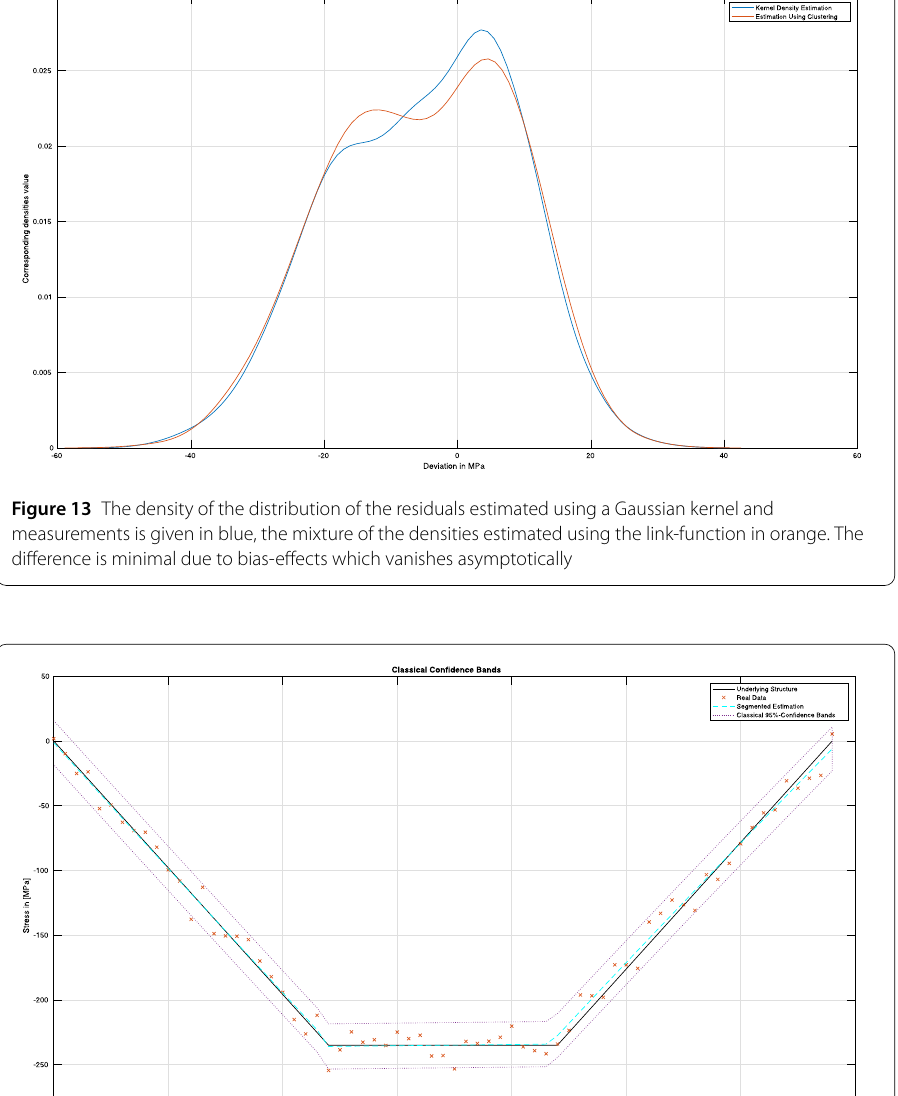
estimation of the stochastic moments possible. It allows the adaption of the confidence band given the distribution of the residuals specifically for all points. Assuming the link- function to be consistent, the parameter of the mixture of Gaussians could be estimated consistently, see Fig. 13 and cf. [24], for details, with known asymptotic distribution and the following confidence bands for a 4-point-bending-test, see Fig. 14 and Fig. 15. Finally, the combination of the yield limit gives bounds for the constants ˜ c and might lead to the decomposition of the constant in residual and normal stress or the identification of plas- ticising areas, see [18] for